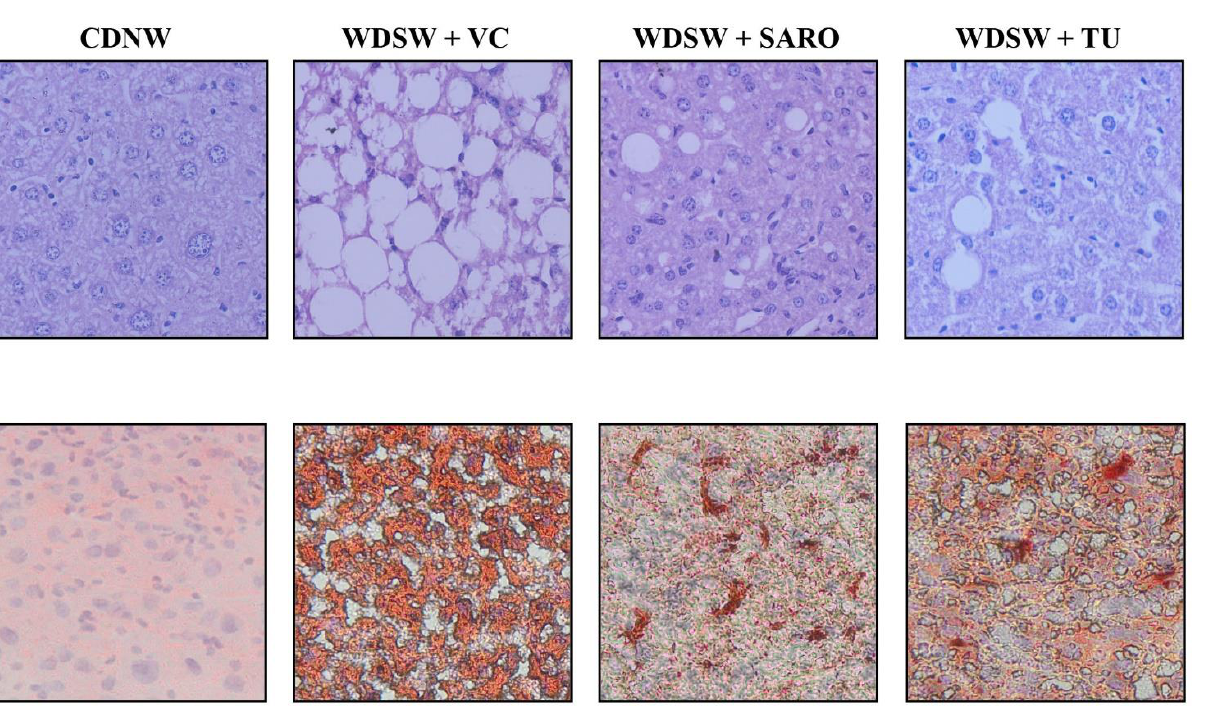
Figure 4. Histological features of mice treated with Tecomella undulata ( TU ) . Representative microscopic views of liver sections from CDNW or WDSW mice treated with vehicle control (VC), saroglitazar (SARO) or Tecomella undulata (TU). Intracellular lipid accumulation was determined by staining with ( A ) hematoxylin and eosin (H&E), and ( B ) Oil Red O. Of note, Tecomella undulata treatment significantly reduced steatosis (1.6 ± 0.2), hepato- cellular ballooning (1.4 ± 0.25), and lobular inflammation (1.8 ± 0.37). The NAFLD activity score in the Tecomella undulata treated mice was significantly lower (4.8 ± 0.6) compared to the WDSW group treated with the vehicle (Figure 5B,E). All of the histological scoring data were promising and were comparable to those of saroglitazar, the positive control